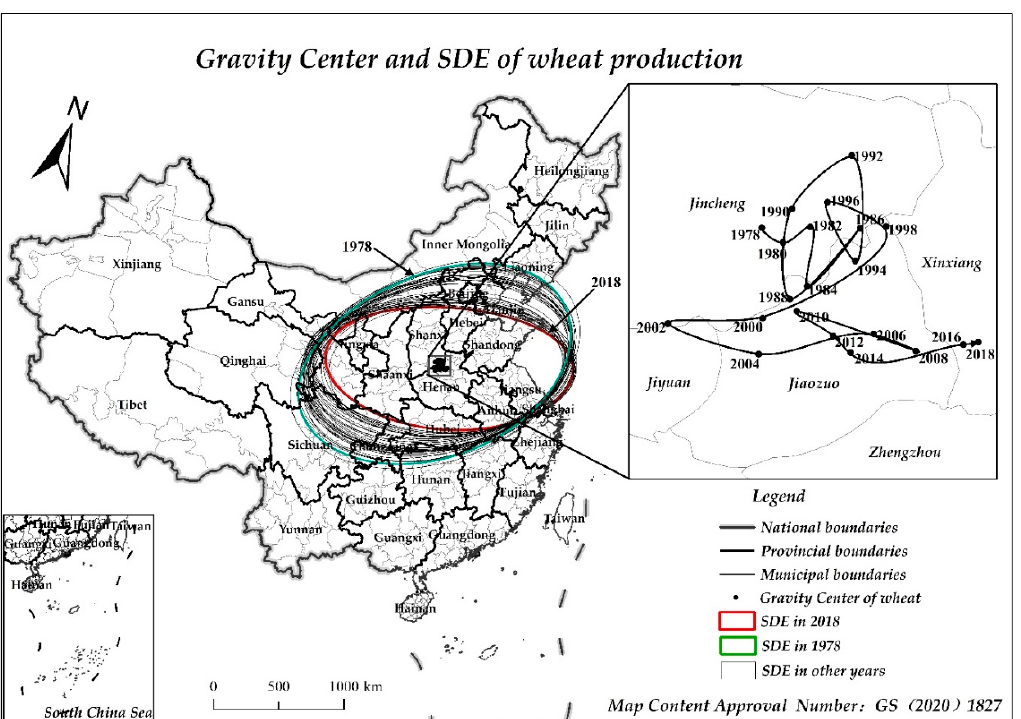
Figure 3. The GC and standard deviation elliptic of wheat production in China since 1978.